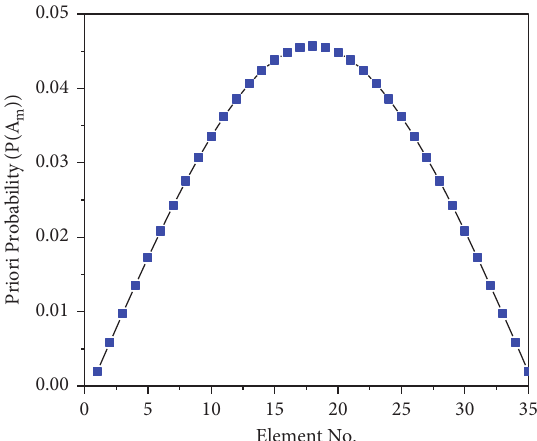
Element No. Figure 30: Damage prior probability of tested simply supported beam.